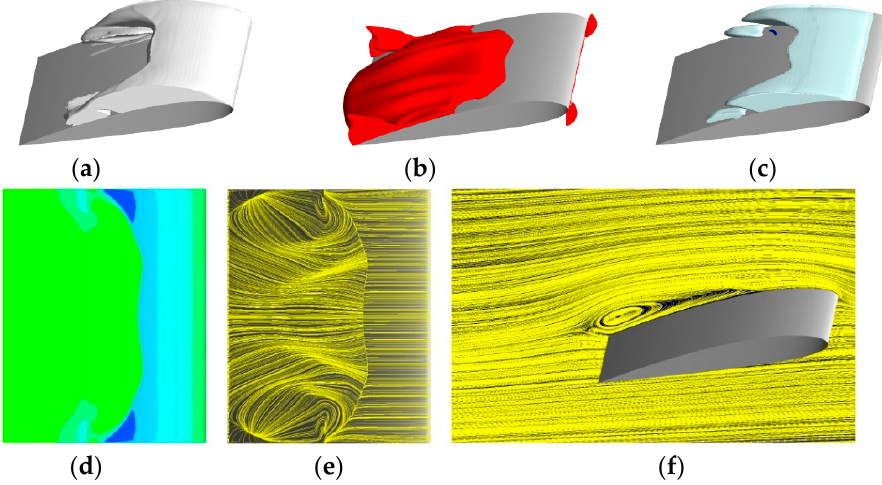
Figure 28. Time instant 8. ( a ) 3D view of cavitation regions (in white); ( b ) back-flow regions (in red);